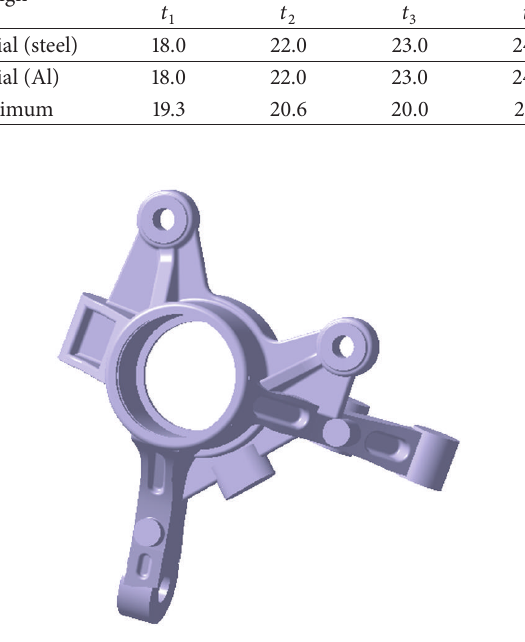
Figure 9: Suggested optimum design of a